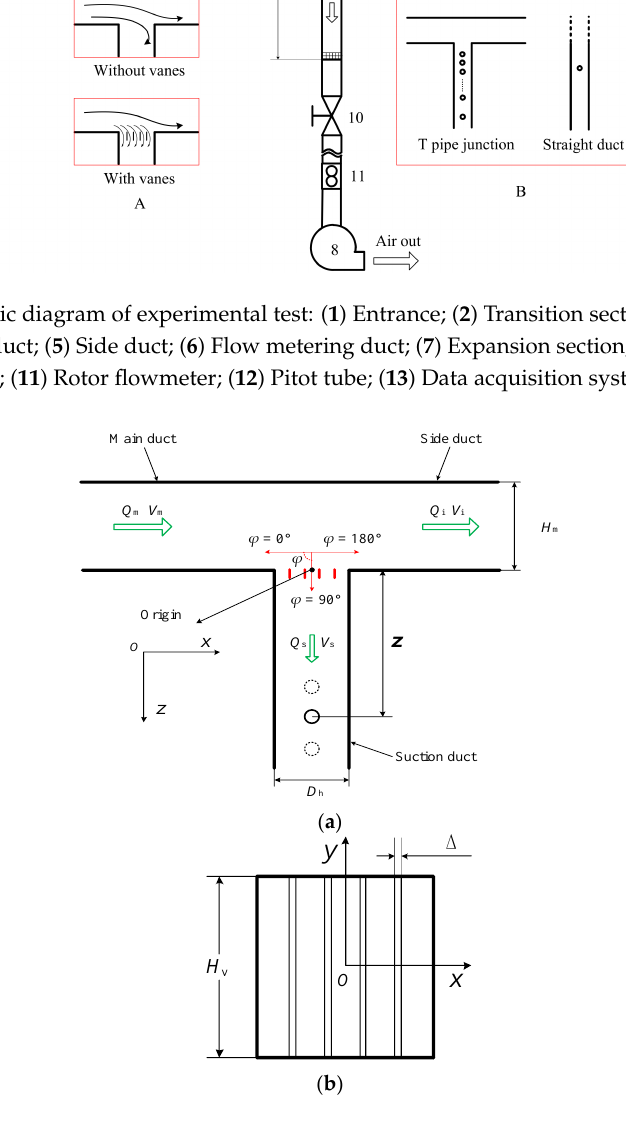
Figure 3. 2D illustration of the T pipe junction: ( a ) planar graph; ( b ) vanes structure.